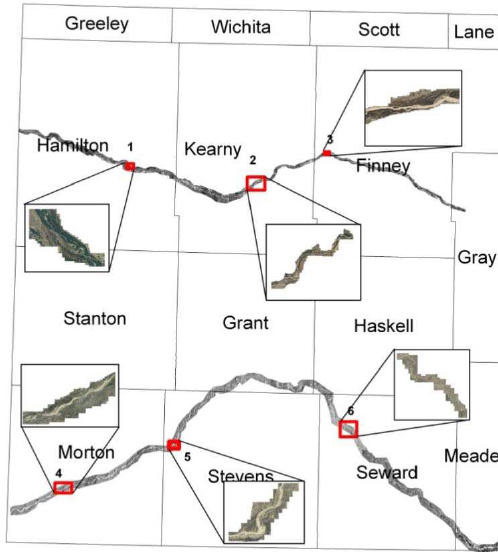
Fig. 2. The study sites and aerial photography along the Arkansas (1, 2 and 3) and Cimarron (4, 5 and 6) Rivers.